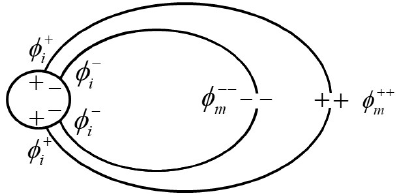
Figure 4. An equatorial projection of the ionospheric potentials ( φ + and φ − ) from the Southern and Northern Hemisphere is illus- i i trated. Ionospheric potentials are positive at higher latitudes ( φ + and negative at lower latitudes ( φ − ). Parallel potential amplified po- i tential difference in the ionosphere during the equatorial projection ( φ ++ m > φ + , φ −− m < φ − ). Earthward electric fields are produced in i i the plasma